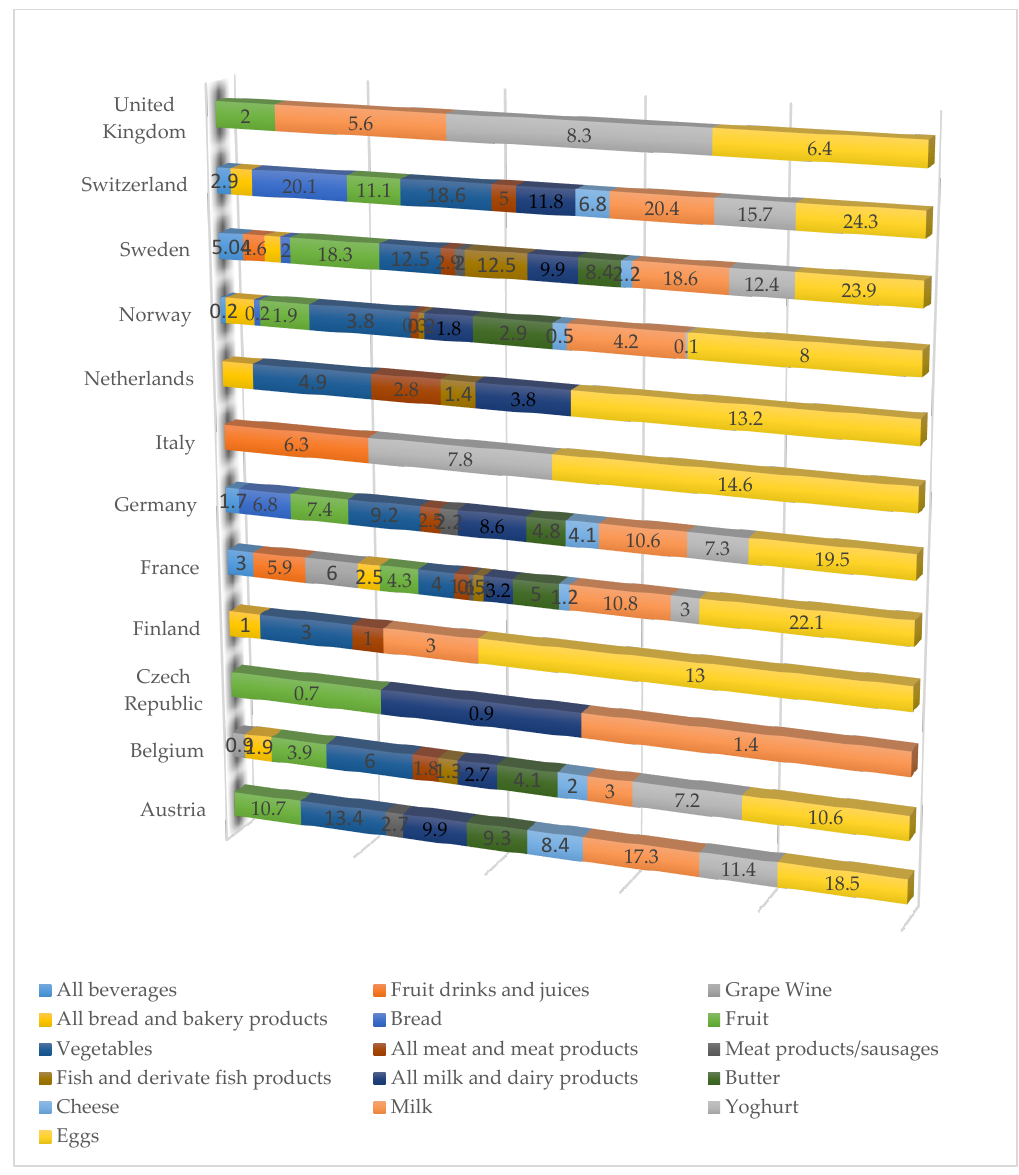
Figure 7. Shares of organic products and product groups of their respective total markets for selected countries in 2015. Source: Austria: AMA Marketing, Belgium, LF based on GFK, Czech Republic: UZEI and experts estimates, Finland: Pro Luomu, France: Agence BIO; Germany: Agricultural market information Company based on GFK; Italy: Asso Bio based on Nielsen; Netherlands: Bionext; Norway: Nielsen Norway; Sweden: Statistics Sweden; Switerland: Bio Suisse; UK: Soil